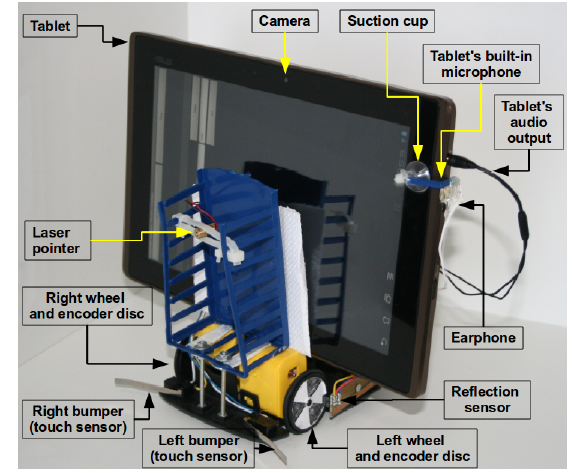
Figure 11. Robot under the control of a tablet computer. The audio output is driven from a P2 connector attached to the earphone jack and the audio input is captured by the built-in microphone of the device. Note the suction cup holding an earphone near the